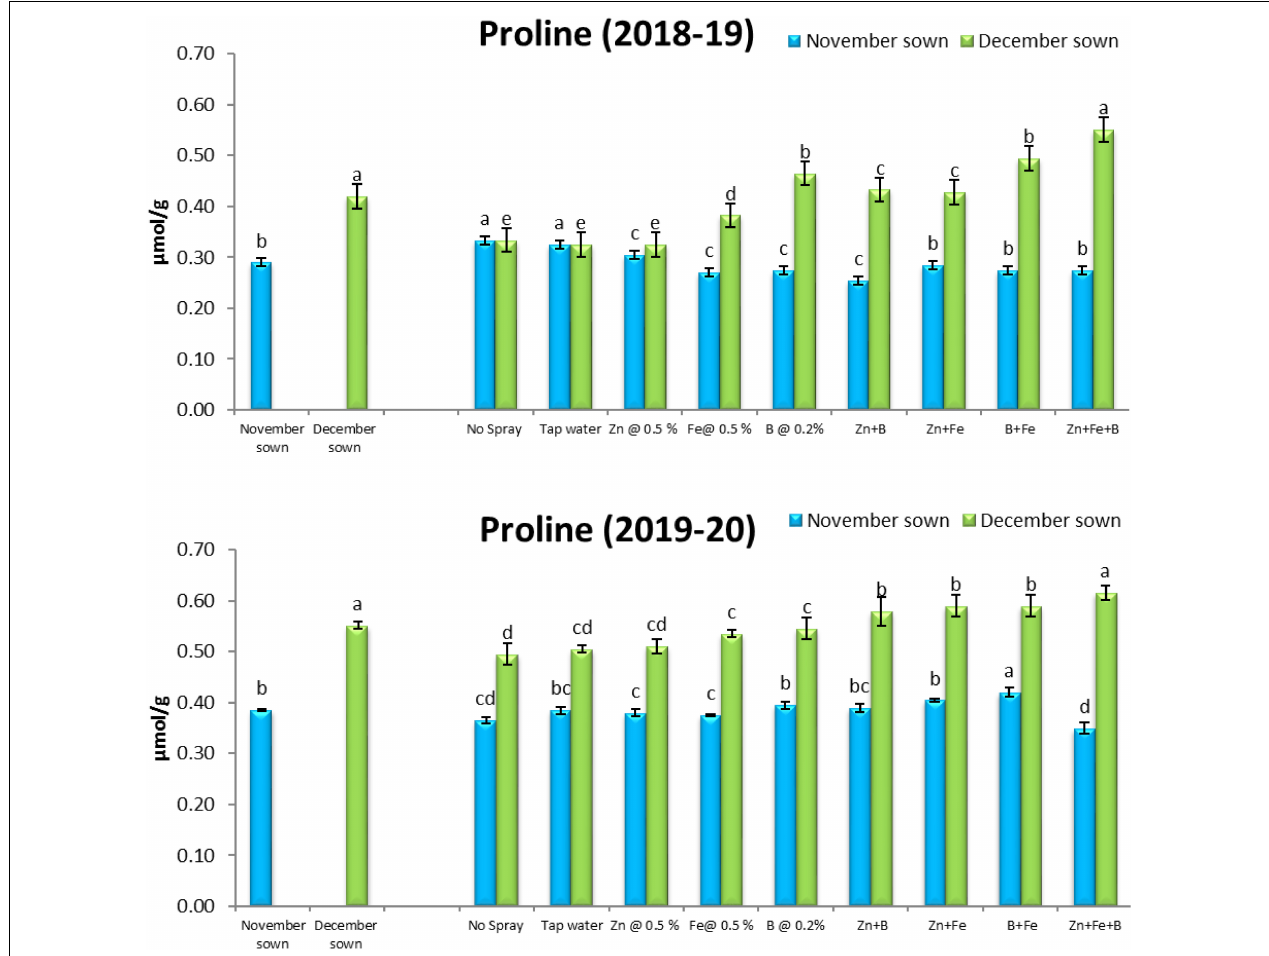
FIGURE 9 | Proline ( µ mol g - 1 ) content for different sowing dates and foliar spray treatments in the 2018–19 and 2019–20 lentil cropping seasons. Values are means, and bars represent ± SEM (n = 3). Different letters indicate significant differences between